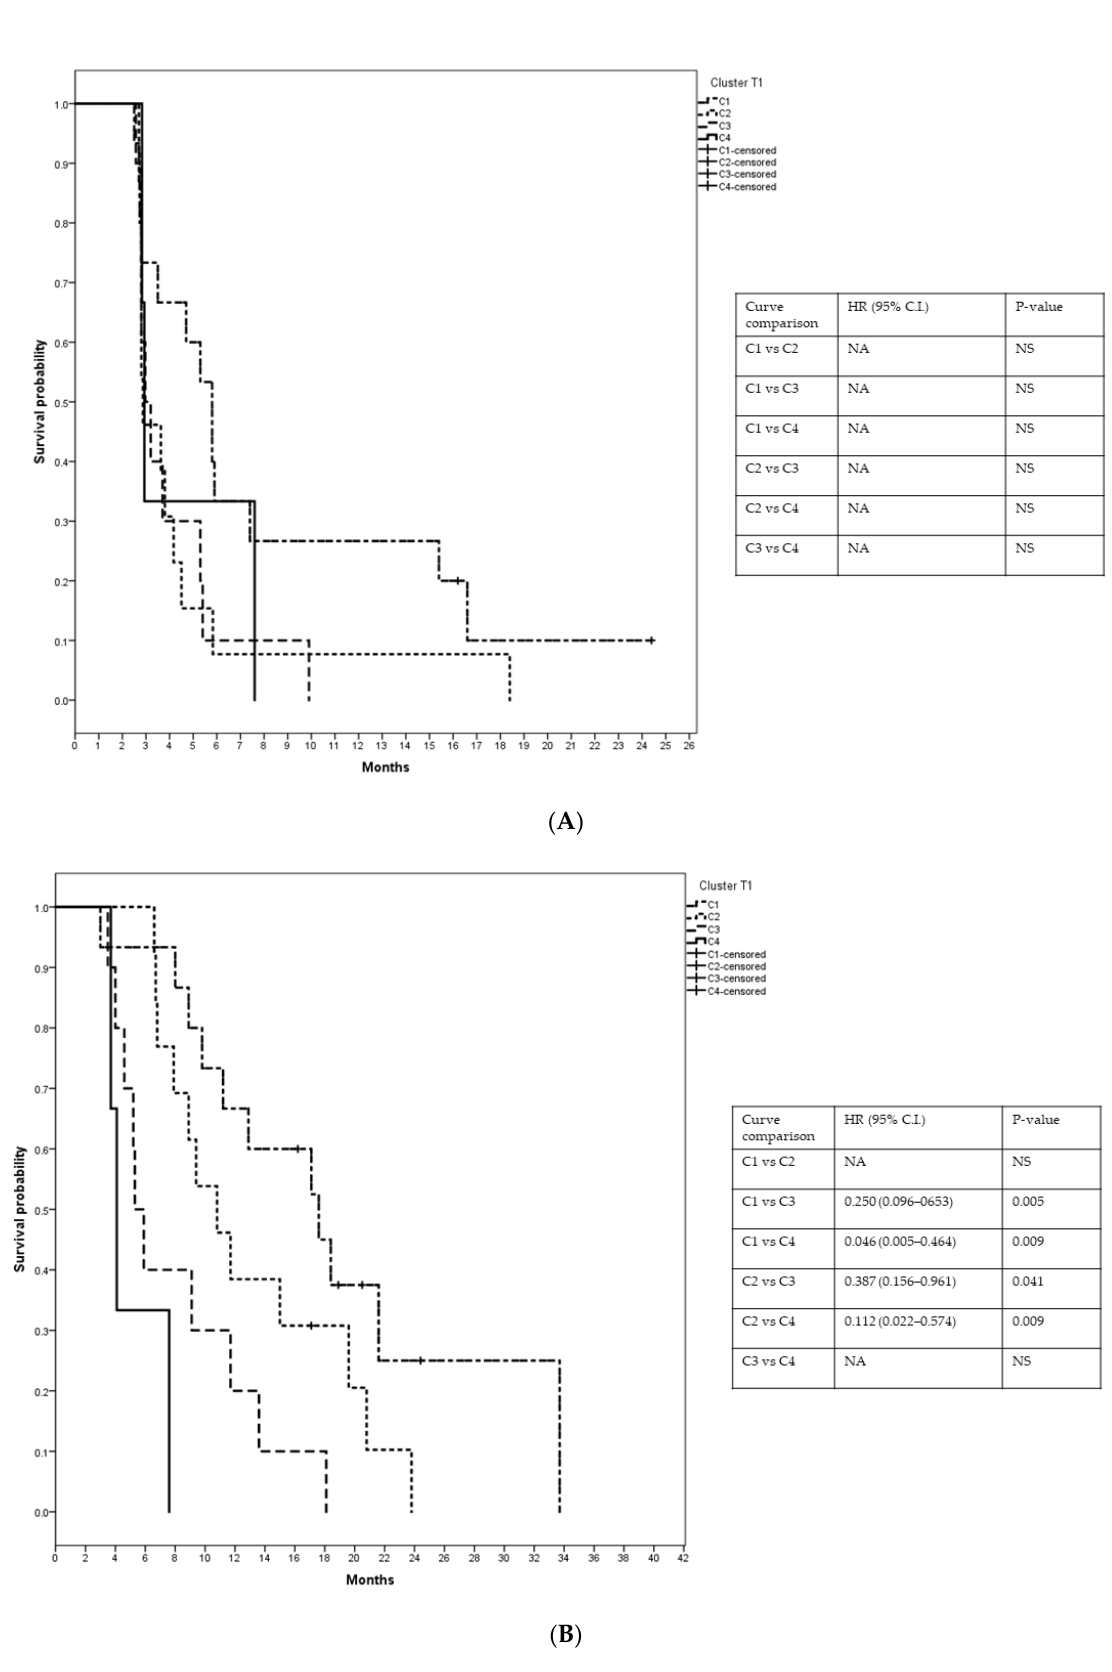
Figure 6. Kaplan–Meyer curves illustrate ( A ) PFS and ( B ) OS of four clusters at T1. NA = not available, NS = not significant.